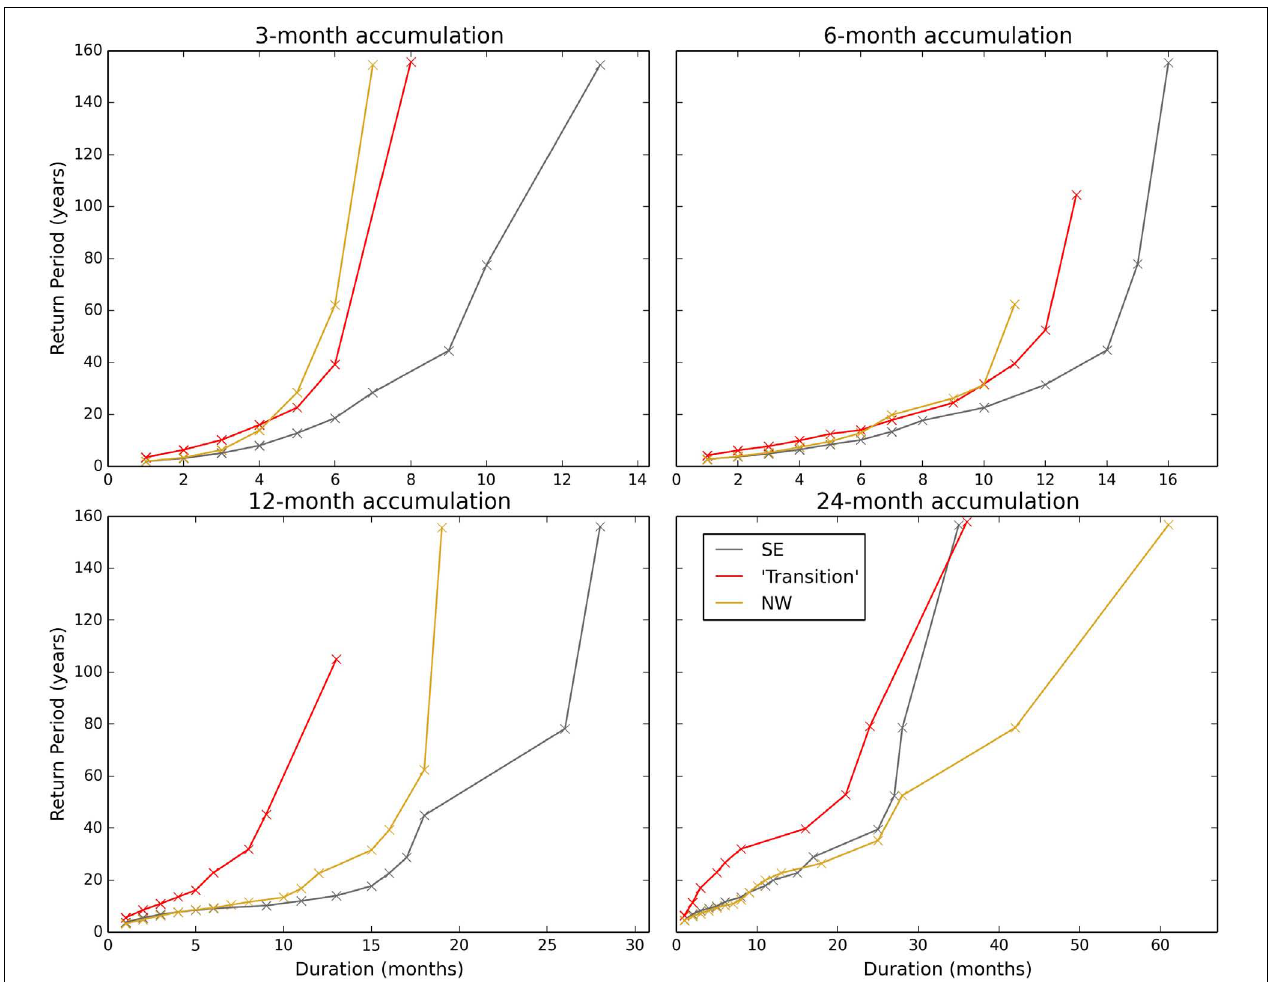
FIGURE 4 | Return period of drought events calculated based on their duration for the three regions of GB, and for different accumulation period of precipitation (3, 6, 12, and 24